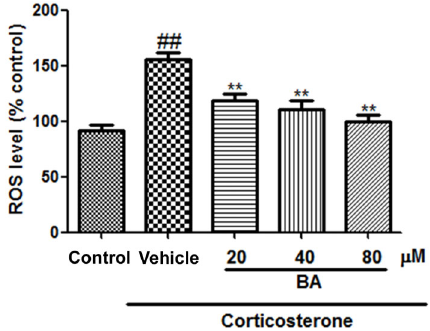
Figure 8. Effects of baicalin (BA) on intracellular reactive oxygen species (ROS) levels in PC12 cells. Data are reported as means ± SE (n=8). ## P o 0.01 vs control; **P o 0.01 vs vehicle